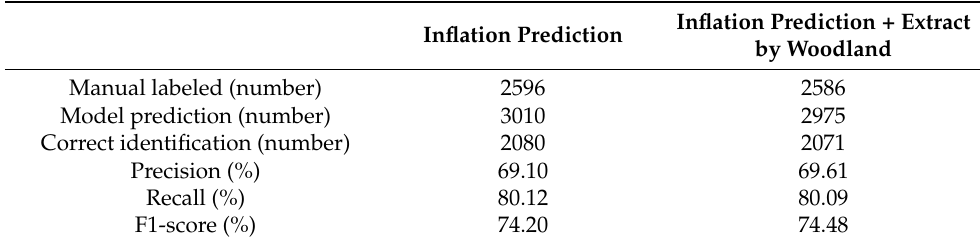
Table 7. Monitoring results of pine wilt nematodes in Shunchang County, Jianou city, and Yanping District.